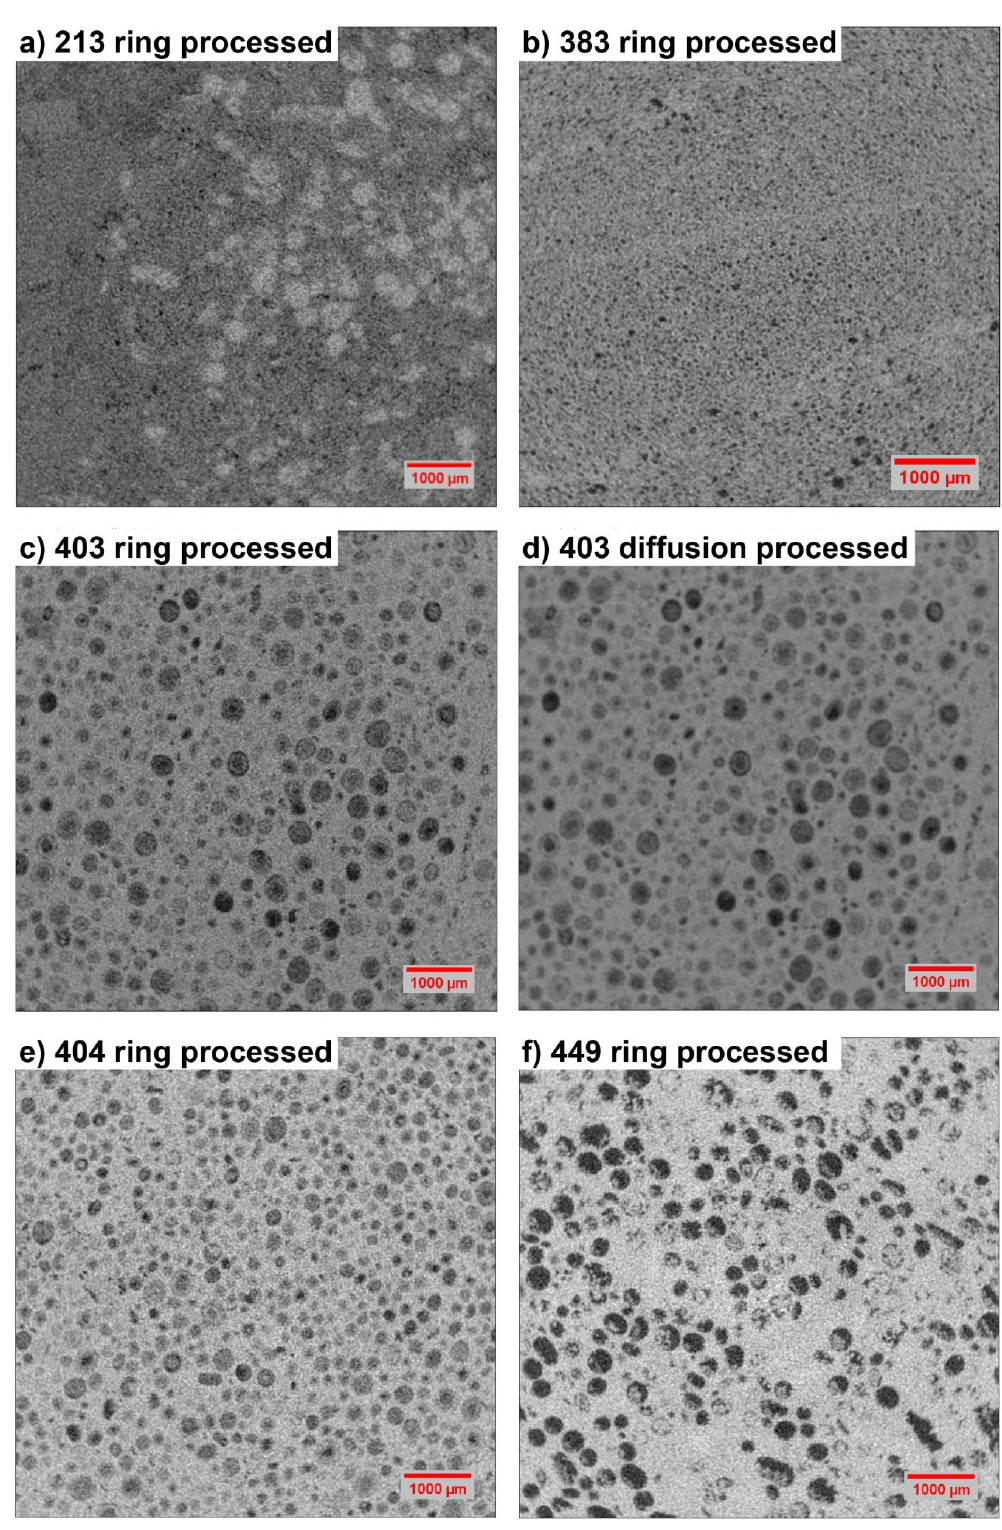
Figure 10. Exemplary slices of the computed tomography (CT)-3D-stack after ring and di ff usion processing. While dark areas represent pores, mineral phases are indicated in grey (dolomite in ( a , b ), calcite in ( c – f )). Anhydrite cemented areas are shown in light grey ( a ). Compared to SEM-derived pore-size distributions, the distribution curves based on di ff usion processing show larger pores (Figure 11a). In contrast, the ring processed distributions show